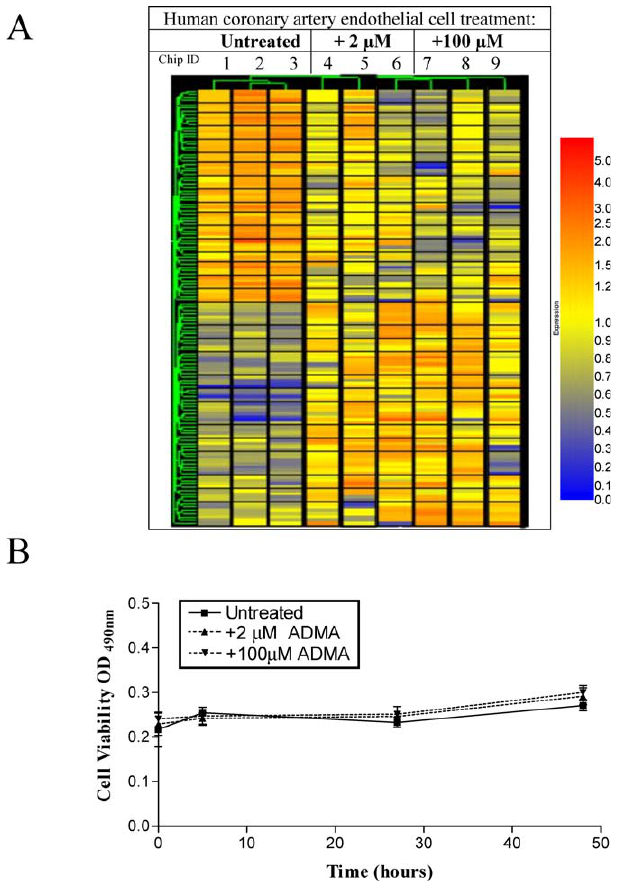
Figure 2. Endothelial Gene Expression Changes in Response to ADMA (A) Changes in HCAEC gene expression in response to ADMA. Hierarchical clustering of 131 genes significantly up- or downregulated ( p , 0.05, Welch t -test) by greater than 1.7-fold on the U133A GeneChips in response to 2 l M ADMA (56 genes) or 100 l M ADMA (86 genes) compared with untreated cells with 11 genes changing with both concentrations of ADMA. Individual arrays are shown for each treatment group with blue representing low expression, and red high expression on the scale bar. (B) Treatment of HCAEC with either 2 l M or 100 l M ADMA had no significant effect on cell viability; n ¼